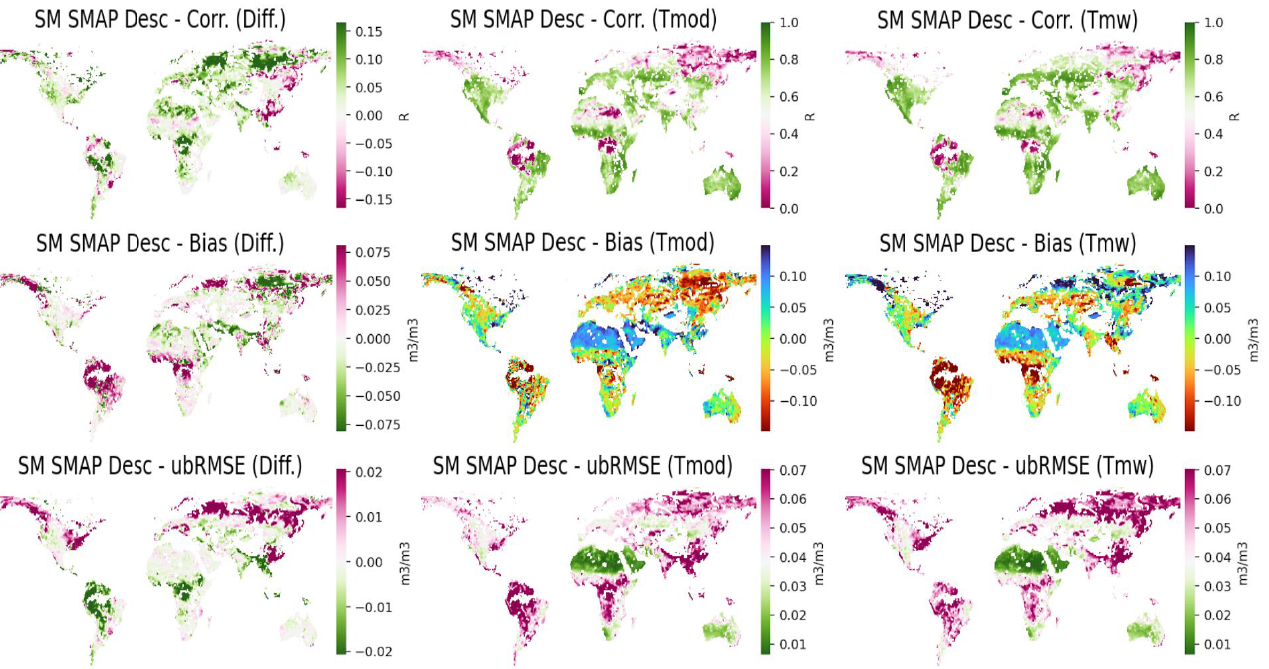
Figure 4. SMAP Desc SM mw and SM mod compared to ERA5. Results are shown for correlation (corr.), bias, and ubRMSE.